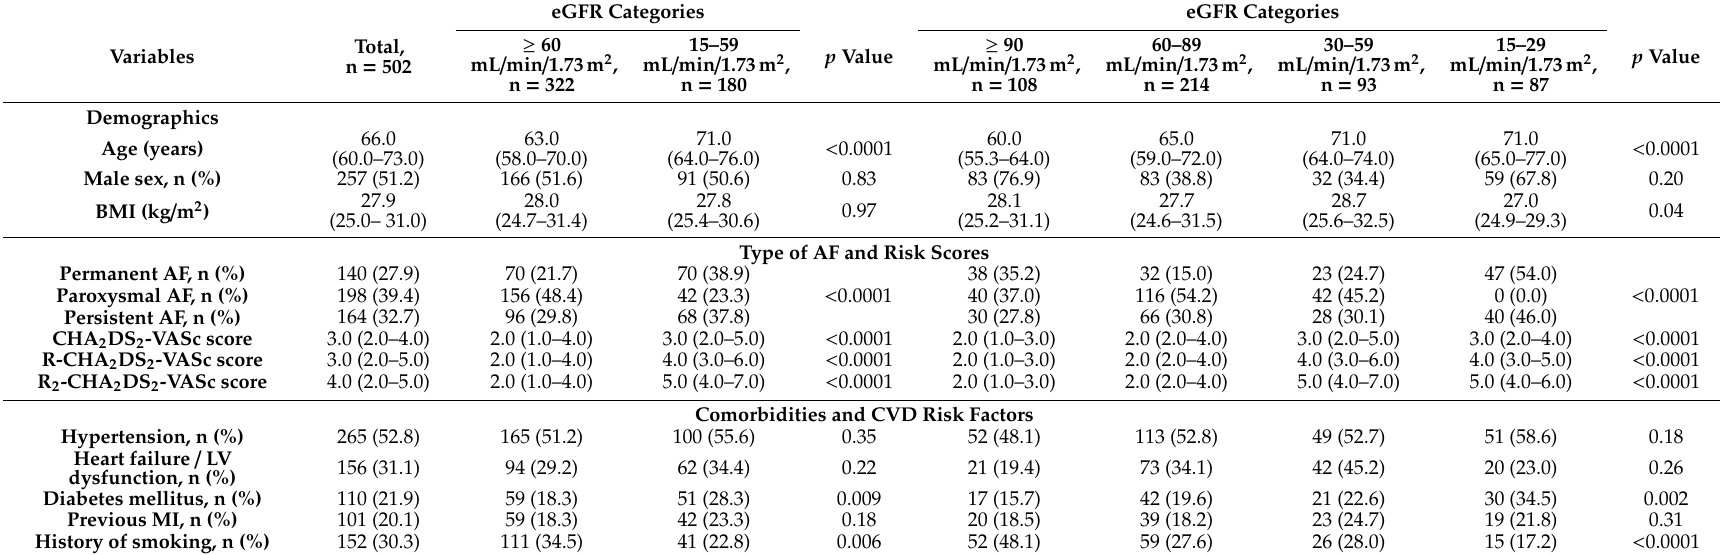
Table 1. Patient characteristics stratified by estimated glomerular filtration rate (eGFR)